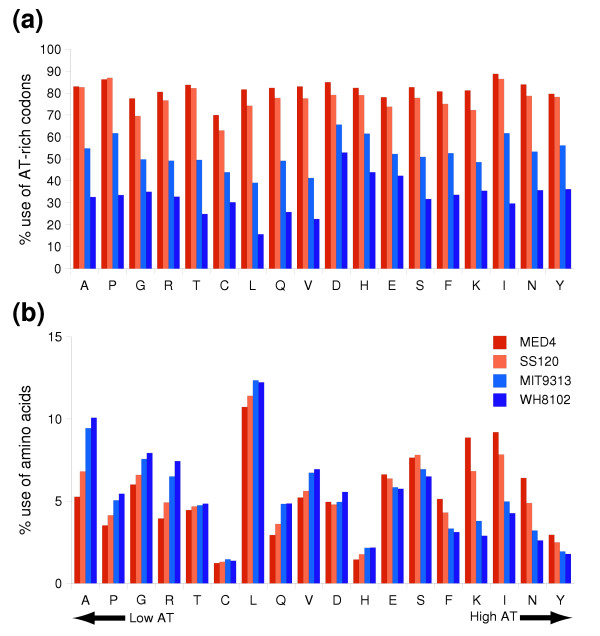
Influence of mutational bias in codon usage and amino-acid usage. (a) Percentage use of AT-rich codons in the four marine picocyanobacteria. Amino acids are ranked according to AT content of their respective codons. Methionine and tryptophan, which are both encoded by only one codon, have been discarded from the analysis. (b) Percentage use of amino acids in marine picocyanobacteria.